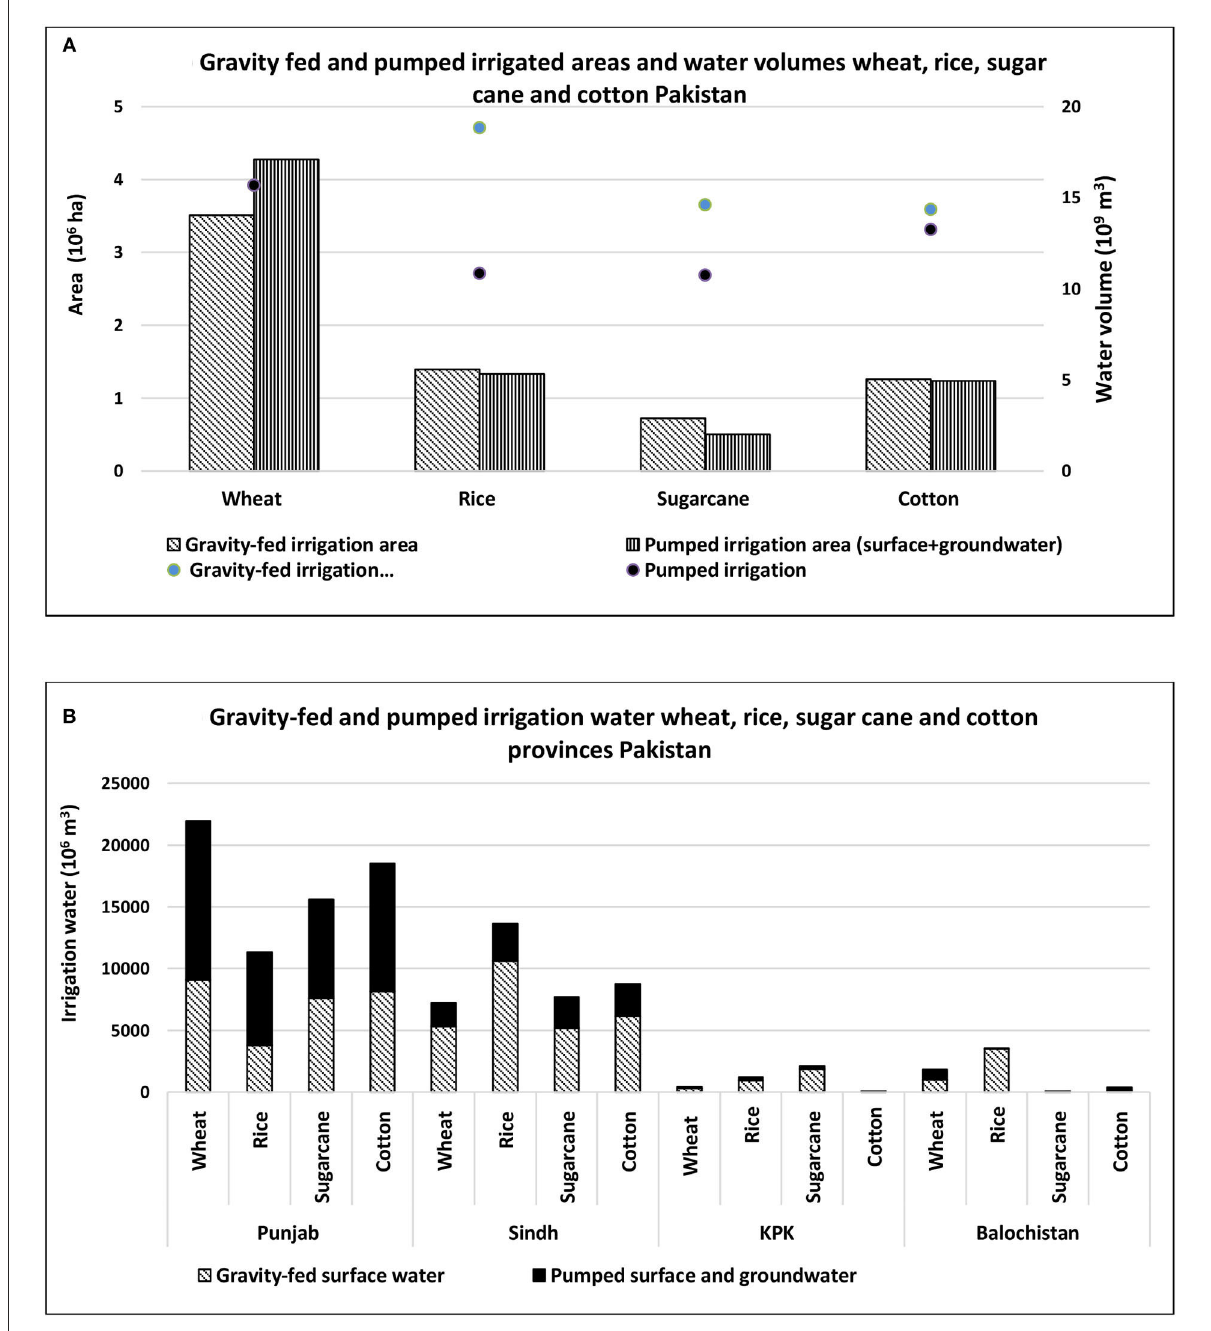
FIGURE3 (A,B) Irrigation areas and water volumes for the four major crops (wheat, rice, sugarcane, and cotton) in the gravity-fed and pumped irrigated areas for the year 2016–17. (A) The areas and water volumes on a national level, and (B) on a provincial level.